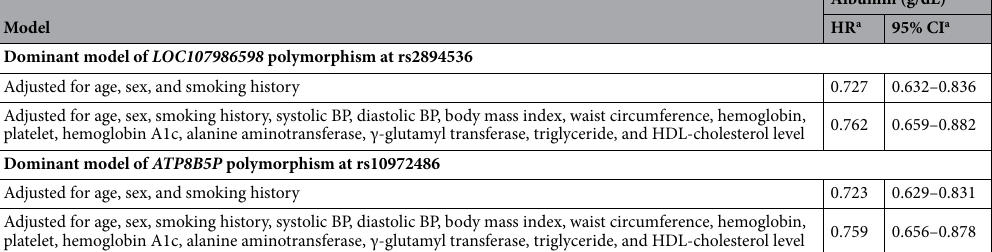
Model Dominant model of LOC107986598 polymorphism at rs2894536 Adjusted for age, sex, and smoking